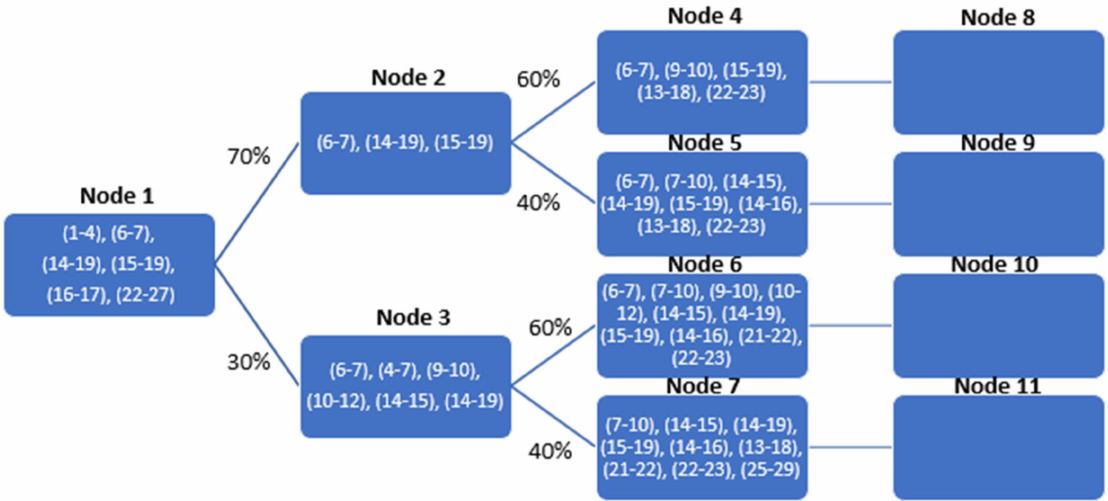
Figure 6. Optimal investment strategy for the case with only conventional investments. The notation (i-j) represents the upgrade of the capacity of the transmission line connected buses (i.e., India states) i and j. Note that the scenario tree depicts investment decisions, i.e., the capacity upgrades will become operational one epoch afterwards (this is why there are no investment decisions taken in the last epoch as there is no epoch5).